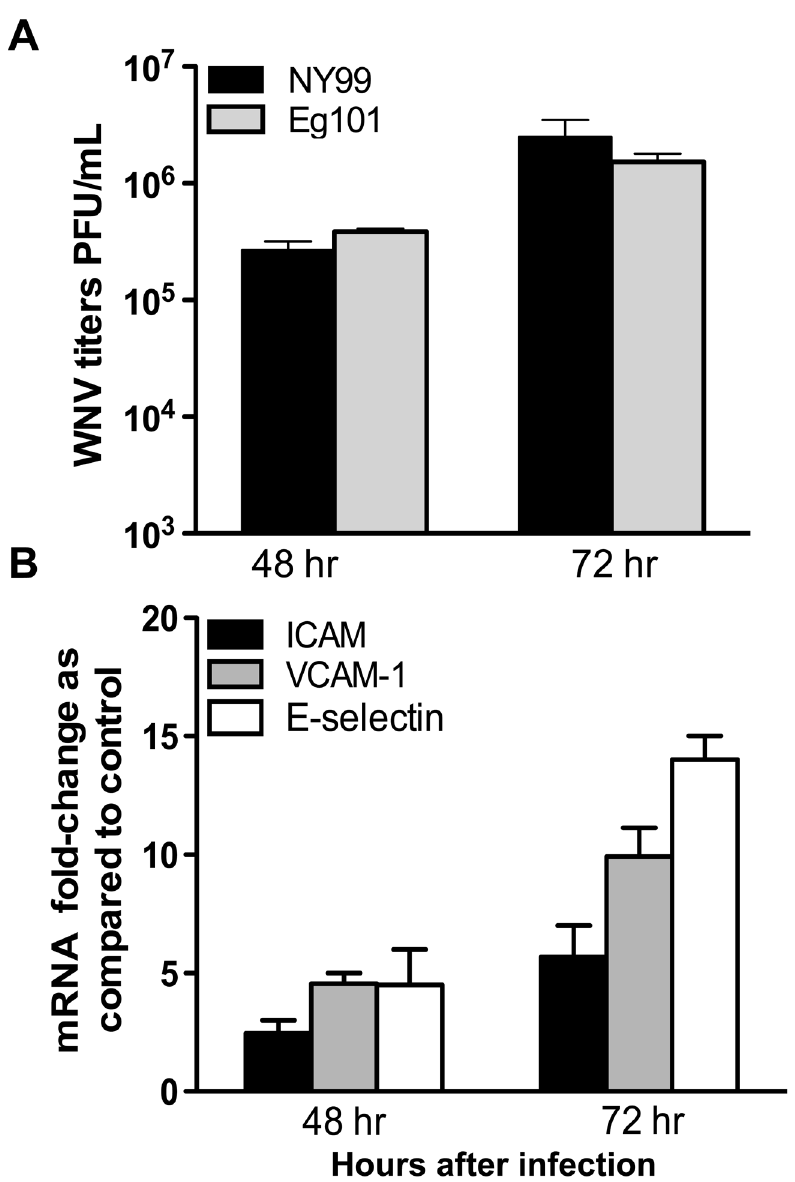
Figure 3. WNV-Eg101 efficiently infects HBMVE cells and induces CAMs. Primary human HBMVE cells were infected with WNV-NY99 or Eg101 (MOI5). ( A ) Culture supernatants recovered at 48 and 72 hrs after infection were used to determine titers using plaque assay on Vero cells. Data represent the mean 6 SD PFU per mL of supernatant from two independent experiments. ( B ) qRT-PCR analysis of CAMs in Eg101 infected HBMVE cells at 48 and 72 hrs after infection. The data are normalized to the values of GAPDH and are expressed as relative fold increase compared to uninfected controls.